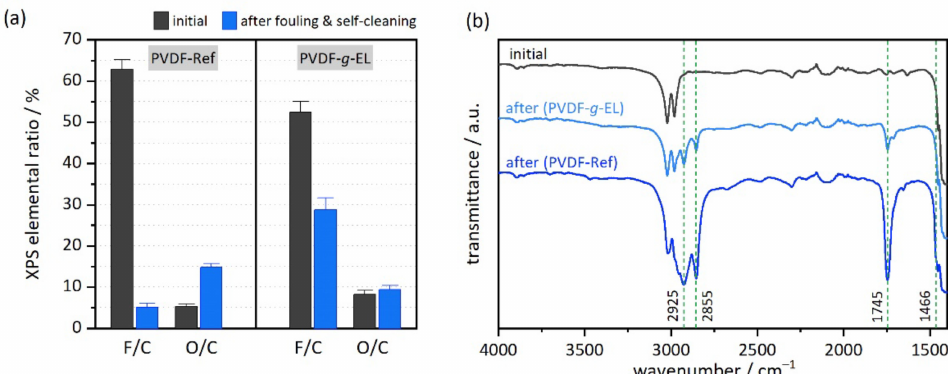
Figure 5. Characterization of samples before and after the first fouling and self-cleaning cycle by using ( a ) XPS; and ( b ) FTIR